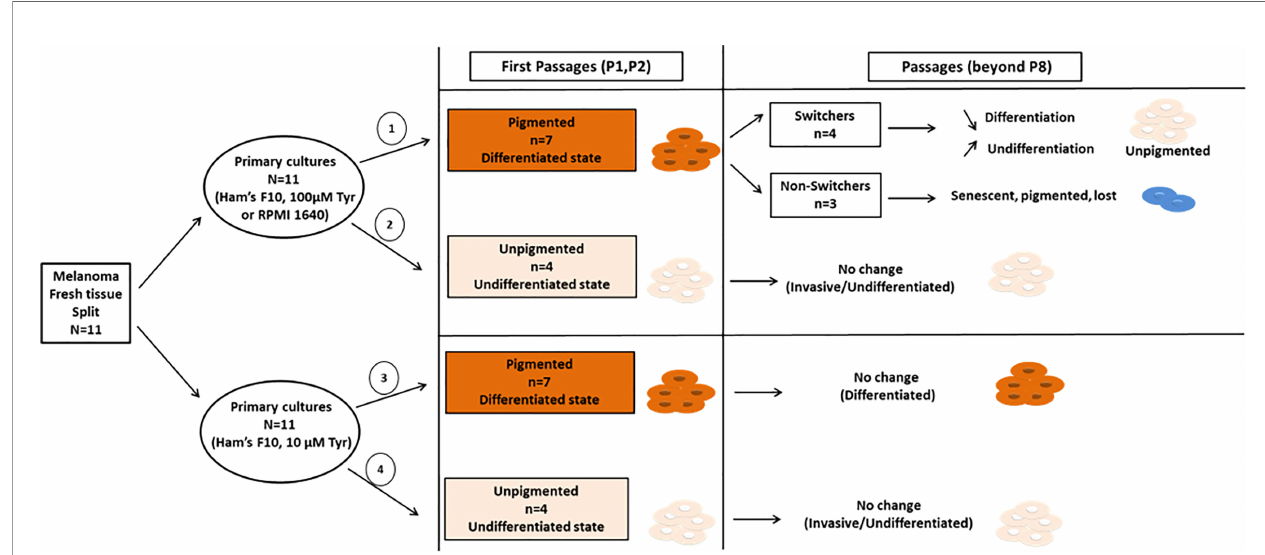
FIGURE 8 | Schematic overview of the results presented in our study. Early primary cultures derived from eleven different patients were split and each primary culture from the same tissue was propagated in two different microenvironmental conditions with low tyrosine (Ham ’ s F10) or high tyrosine (Ham ’ s F10 supplemented with tyrosine; or RPMI 1640). Out of eleven primary cultures, seven initially displayed highly differentiated pigmented phenotype (cell pellets, passages 1-2), and four primary cultures displayed an invasive/undifferentiated unpigmented phenotype (cell pellets, passages 1-2). Row 1, High tyrosine medium (Ham ’ s F10 supplemented with tyrosine or RPMI 1640) promotes an early phenotypic switch (passage 8 and beyond) in originally primary cultures (n=7) towards an invasive/undifferentiated phenotype (switchers, n=4) or senescence-like phenotype (non-switchers, n=3). Row 2 and 4, The “ unpigmented ” primary culture group (n=4) presented at once with an inherent invasive/undifferentiated phenotype, with no phenotypic changes during passages, and independently of tyrosine content in culture media. Row 3, In low tyrosine culture medium, the pigmented cultures (n=7) did not switch or change pigmentation and have not been lost. These cultures keep their highly differentiated phenotype of the original